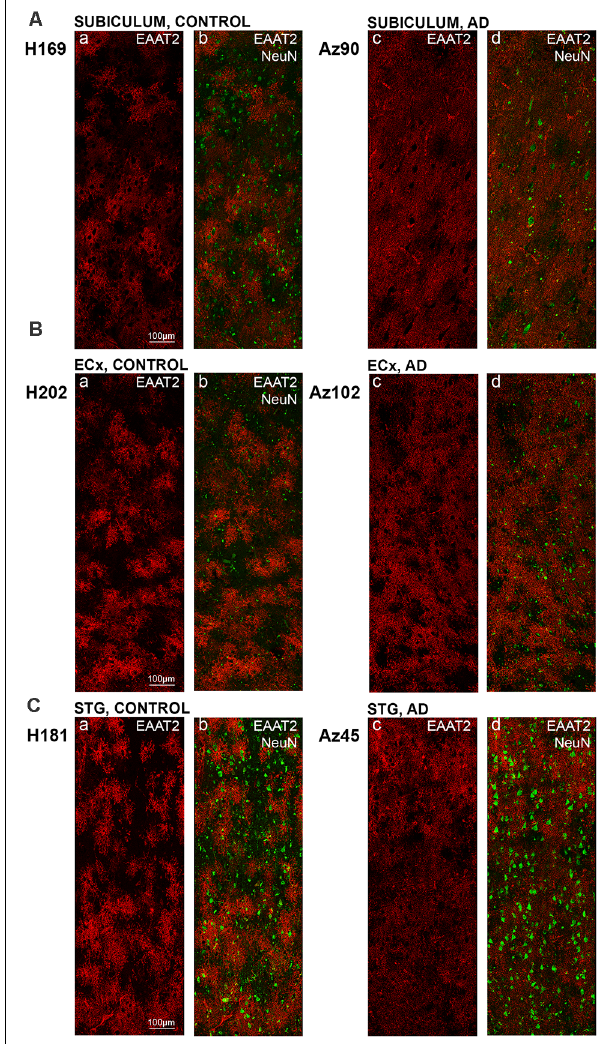
FIGURE 4 | EAAT2 expression in the subiculum, entorhinal cortex, and superior temporal gyrus in human control and Alzheimer’s disease (AD) cases. Photomicrographs of representative regions of the subiculum (A) , entorhinal cortex (B) , and STG (C) showing EAAT2 (red) and EAAT2 overlaid with NeuN (green) immunoreactivity for representative AD and control cases. AD, Alzheimer’s disease; CA, cornu ammonis; DG, dentate gyrus; ECx, entorhinal cortex: STG, superior temporal gyrus. Scale bars (A–C) = 100 µ m.